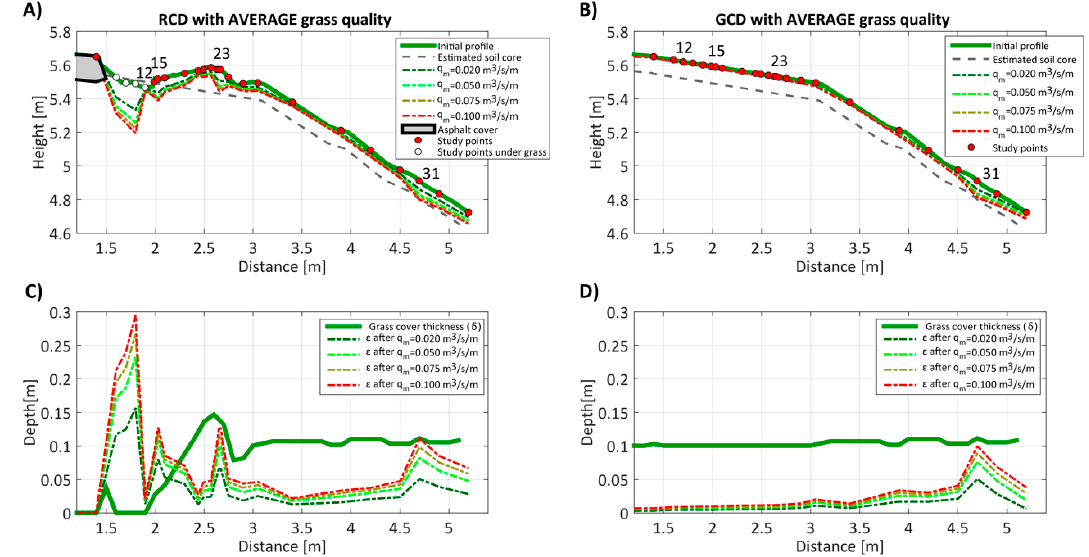
Figure 12. Results of scoured profiles for different q m conditions on average grass quality for ( A ) RCD and ( B ) GCD. Lower plots show their initial grass cover thickness ( δ ) and the eroded depths ( ε ) after each storm condition for ( C ) RCD and ( D ) GCD.